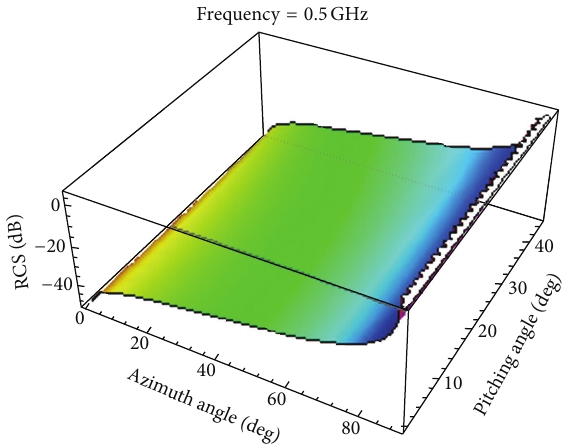
Figure 11: The elliptical cylinder backscattered RCS for 𝜃,𝜑 .